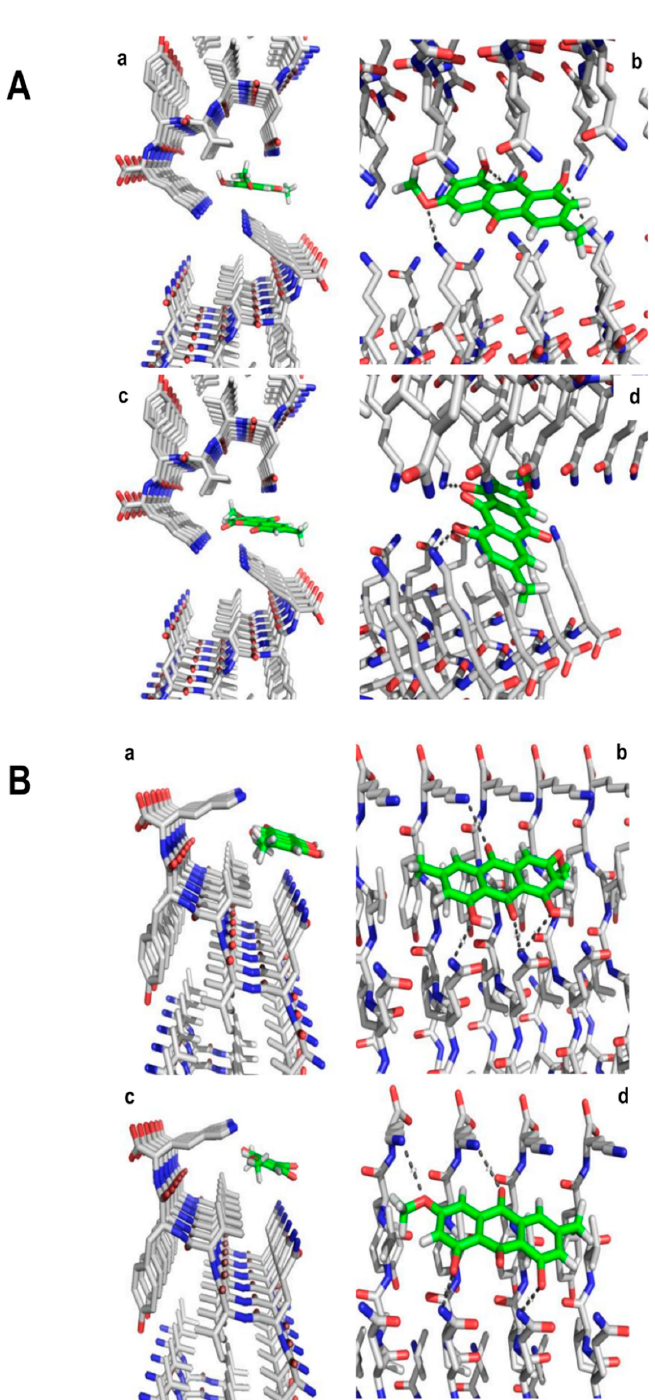
Methods section. We docked parietin structures inside a cavity formed between two steric zippers between two steric zippers (model A) and on the surface of one steric zipper (model B); models A (model A) and on the surface of one steric zipper (model B); models A and B (Figure 3). and B (Figure 3).